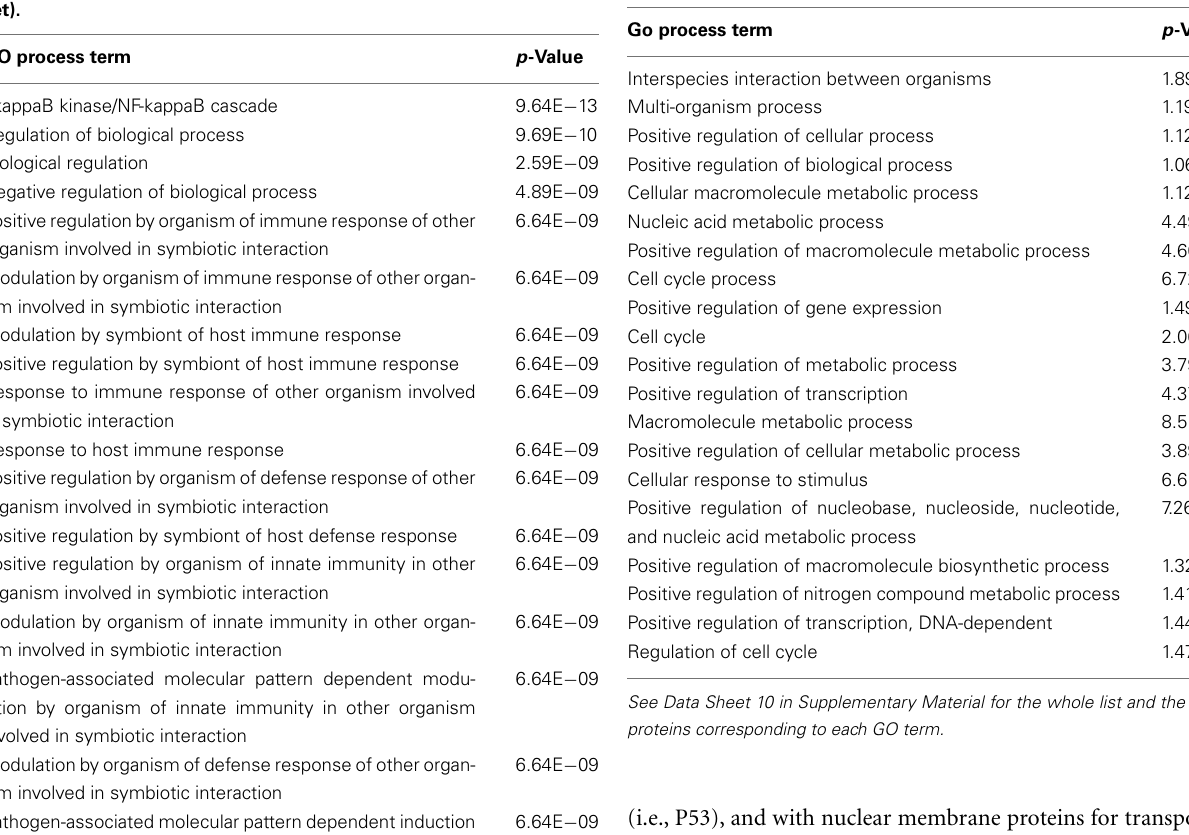
Table 4 | First 20 enriched GO process terms in human proteins targeted by at least three viral groups (three-viruses-targeted